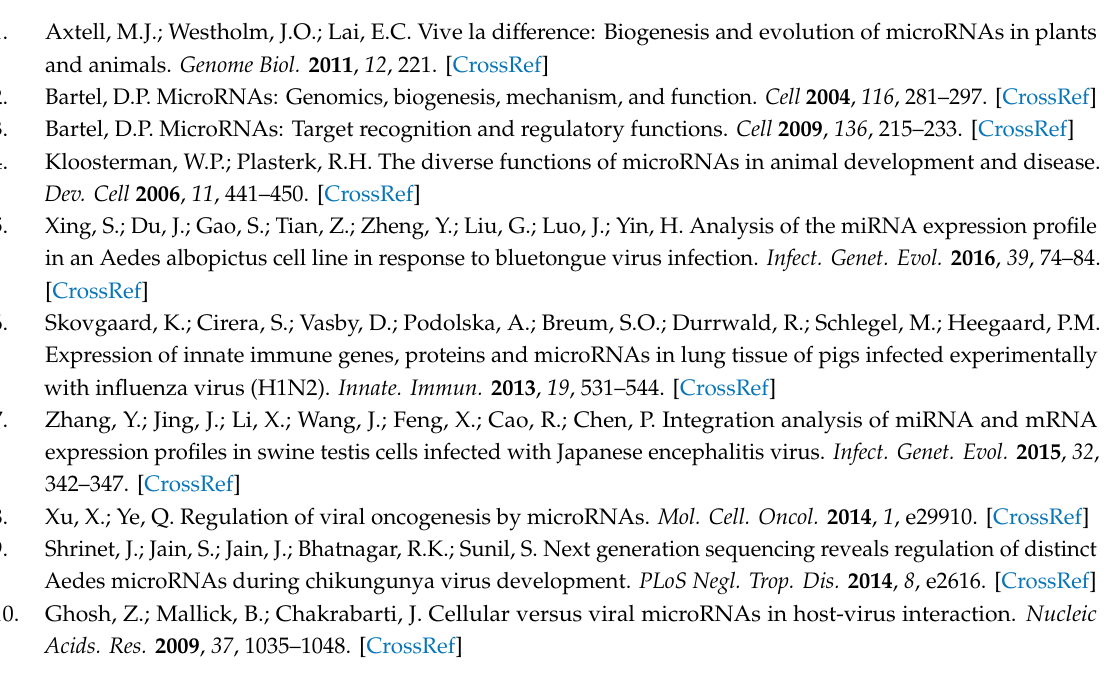
Table S1. Summary of deep sequencing data of each library are shown in the table. File S1: Di ff erentially expressed known and novel miRNAs at mock and two di ff erent time points of PPR vaccine virus inoculated PBMC cell samples, File S2: Di ff erentially expressed known and novel miRNAs in mock and PPR vaccine virus inoculated ST cell samples, File S3: Target genes for di ff erentially expressed known and novel miRNAs at mock and two di ff erent time points of PPR vaccine virus inoculated PBMC cell samples, File S4: Target genes for di ff erentially expressed known and novel miRNAs in mock and PPR vaccine virus inoculated ST cell samples, File S5: GO annotations for the predicted target genes for known and novel miRNAs at mock and two di ff erent time points of PPR vaccine virus inoculated PBMC cell samples, File S6: GO annotations for the predicted target genes for known and novel miRNAs in mock and PPR vaccine virus inoculated ST cell samples, File S7: KEGG Pathway annotations for the predicted target genes for di ff erentially expressed known and novel miRNAs at mock and two di ff erent time points of PPR vaccine virus inoculated PBMC cell samples, File S8: KEGG Pathway annotations for the predicted target genes for di ff erentially expressed known and novel miRNAs in mock and PPR vaccine virus inoculated ST cell